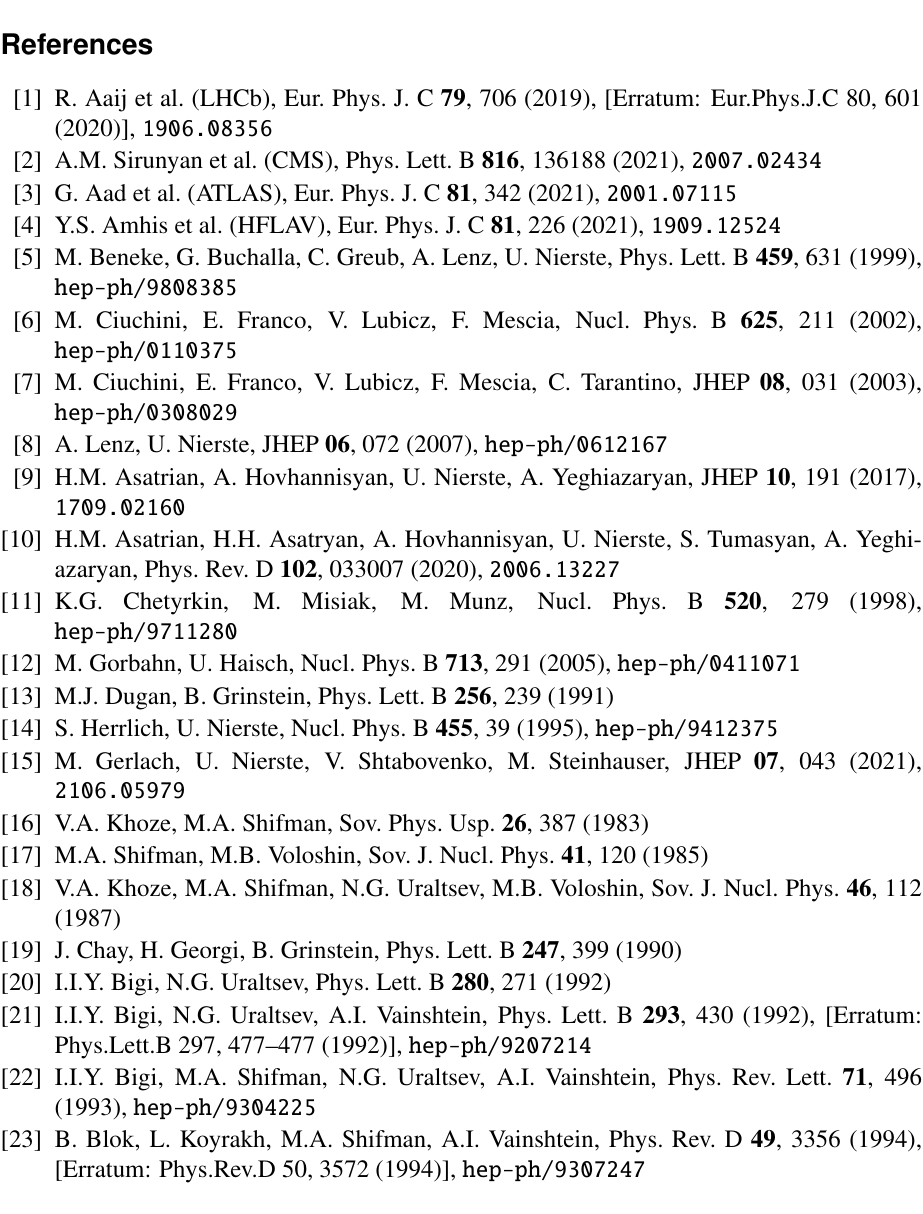
Table 1. Overview of the results obtained in the course of this